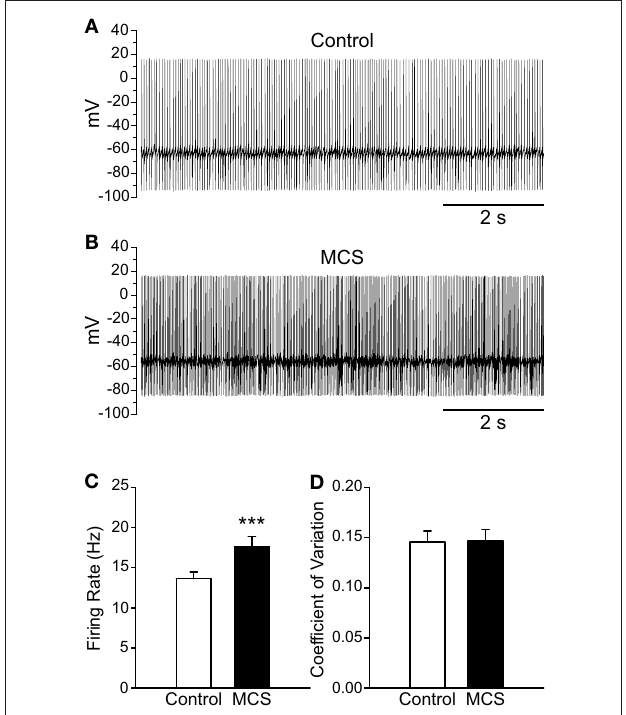
FiGuRe 3 | Amplifying endogenous H neuron firing rate. (A) Spontaneous firing from a SNr GABAergic neuron under control conditions and (B) after inhibition of GSH peroxidase with mercaptosuccinate (MCS; 1 mM). (C) Amplifying endogenous H unaffected by increasing endogenous H